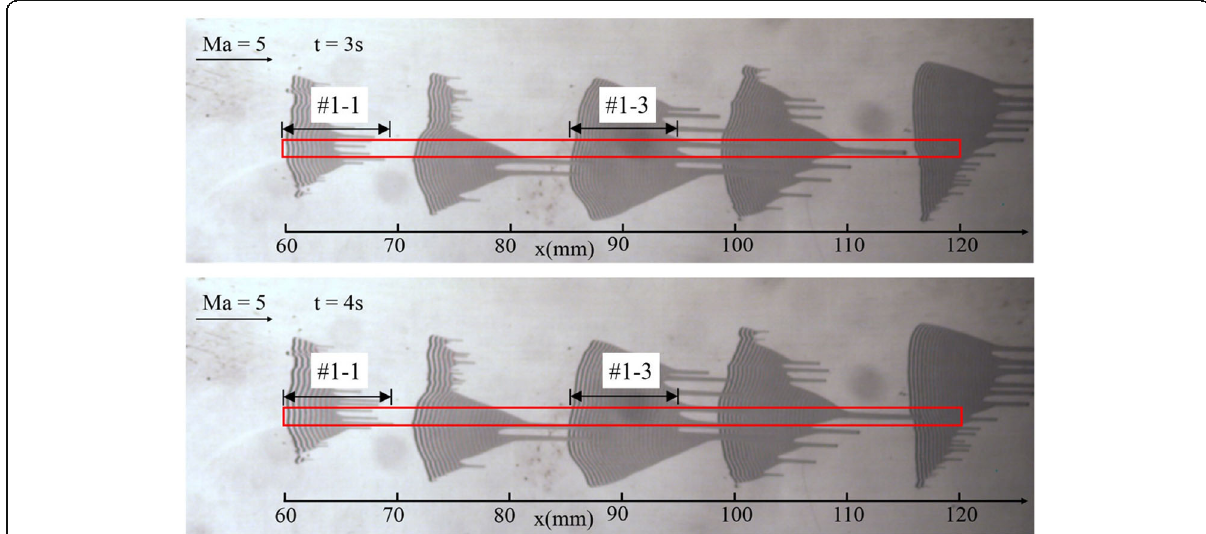
Fig. 8 Baseline oil film pattern at t = 3 s and 4 s for free stream without roughness element